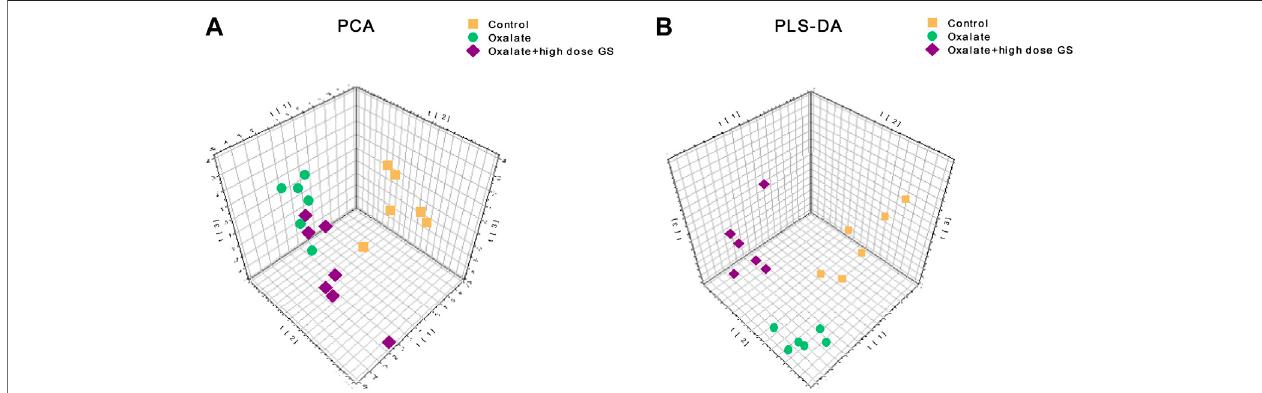
FIGURE 4 | PCA and PLS-DA score plots in ESI positive ion mode. (A) PCA score plots based on the urine metabolic pro fi les of the control group, oxalate group and oxalate + high-dose GS group. (B) PLS-DA score plots of urine samples obtained from the control group, oxalate group and oxalate + high-dose GS